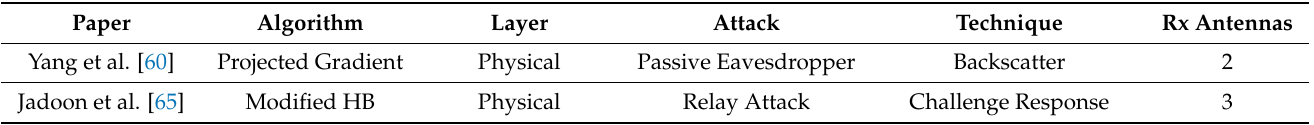
Table 3. Comparison of various security schemes for MIMO